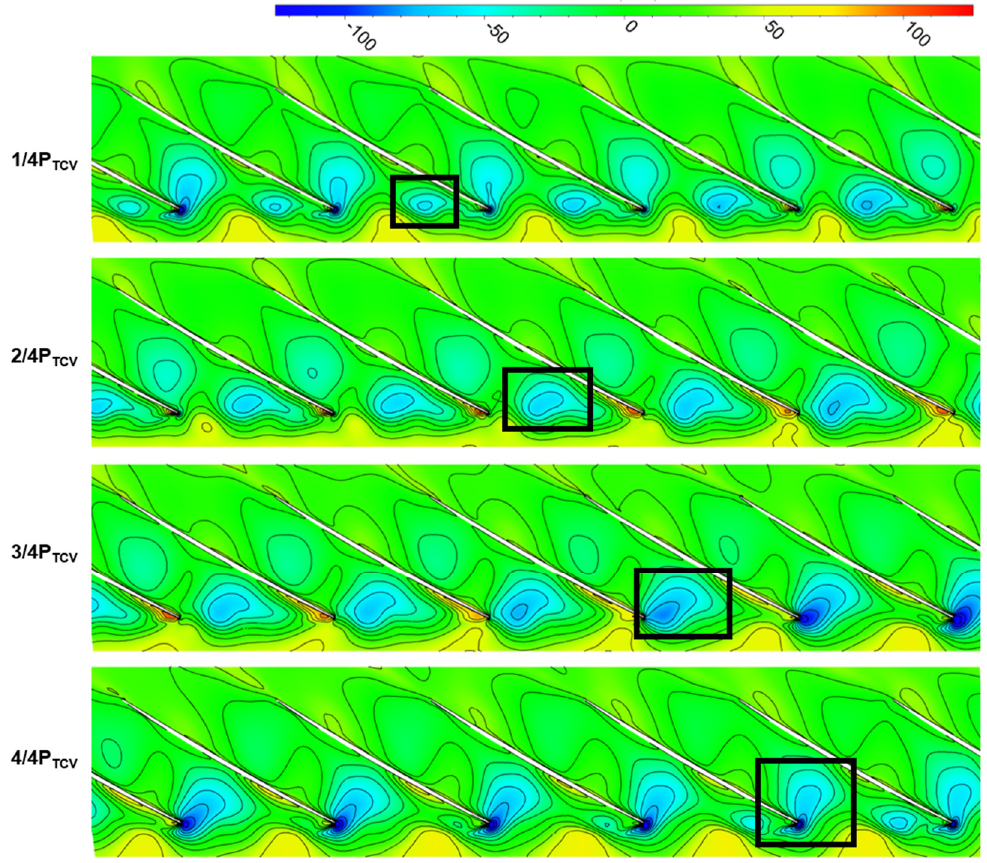
Figure 17. Unsteady contours of axial component of velocity. (P TCV is the period of the TCV (tip clearance vortex) shedding).